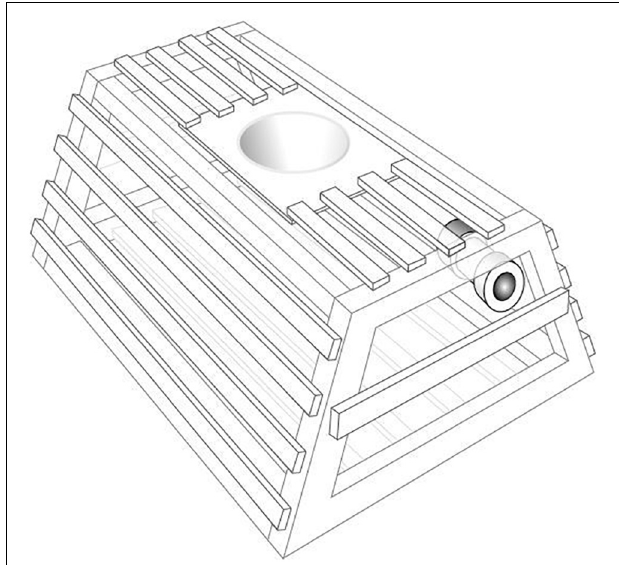
FIGURE 2 | A diagram of a western rock lobster fishery trap with POTBot installed. Wooden batten rock lobster pots have a maximum internal length of 91.5 cm long, 80 cm wide and 42 cm